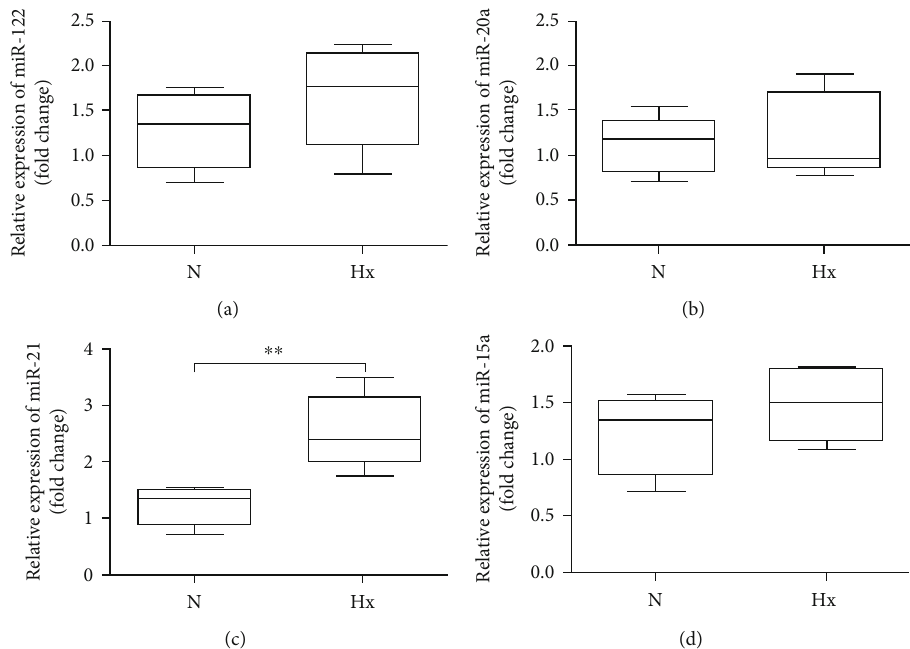
Figure 2: Expression levels of exosome-related miRNA produced by KEL cells under hypoxia or normoxic condition. The expression levels of exosome-related miRNA were detected by RT-PCR. The statistical assay of (a) miR-122, (b) miR-20a, (c) miR-21, and (d) miR-15a contained in exosomes. N: normoxia; Hx: hypoxia. ∗∗ P < 0 : 01